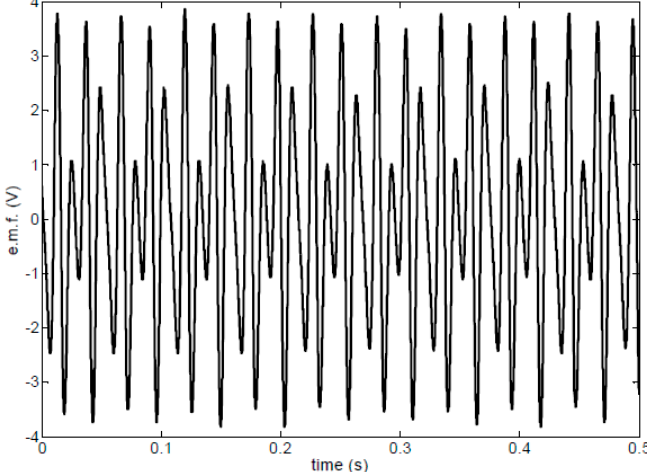
Figure 4. Oscillation frequency as function of wind velocity.